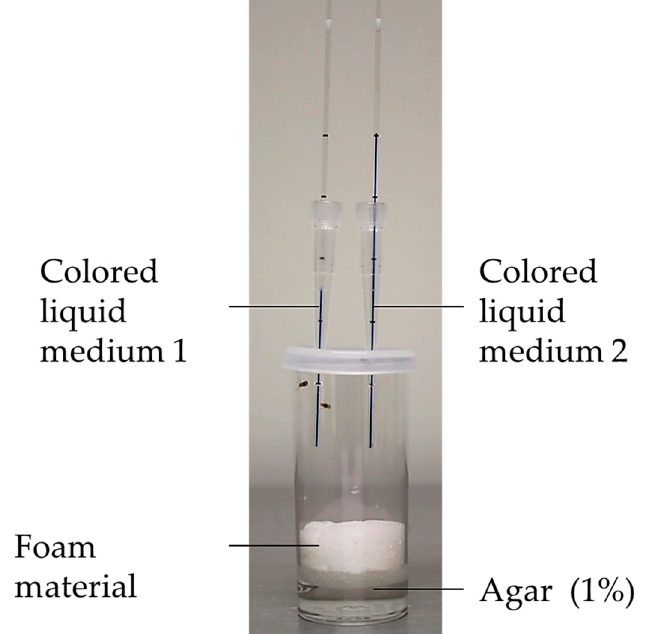
Figure 6. CApillary FEeder (CAFE) assay. The CAFE assay can be used for quantification of food intake and for food choice experiments. Flies are transferred into a vial, which is closed with a lid with small air holes. Capillaries filled with liquid medium and placed into pipette tips are inserted vertically through these air holes. Subsequently, the vials are kept in a storage box to maintain a constant humidity level. The flies absorb the liquid food by feeding on the lower ends of the capillaries. As time passes, the fill volumes of the capillaries decrease. The amount of ingested food can be calculated by measuring the fill levels of each capillary at the start and end of the CAFE assay (modified from [65,66]).